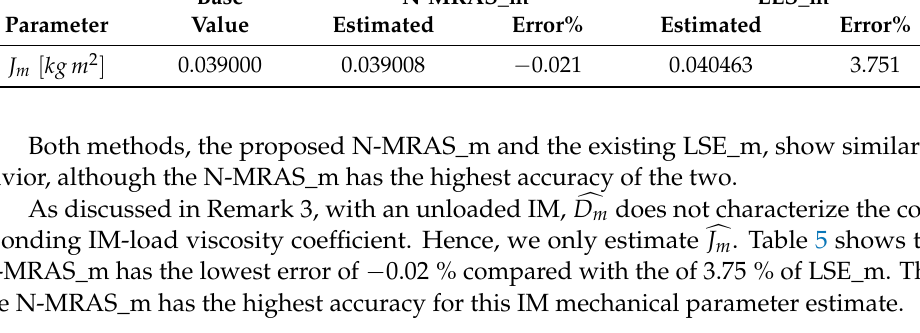
Table 5. Comparative results for the IM mechanical parameters estimate. Base N-MRAS_m LES_m Parameter Value Estimated Error% Estimated Error% J m [ kg m 2 ] 0.039000 0.039008 − 0.021 0.040463